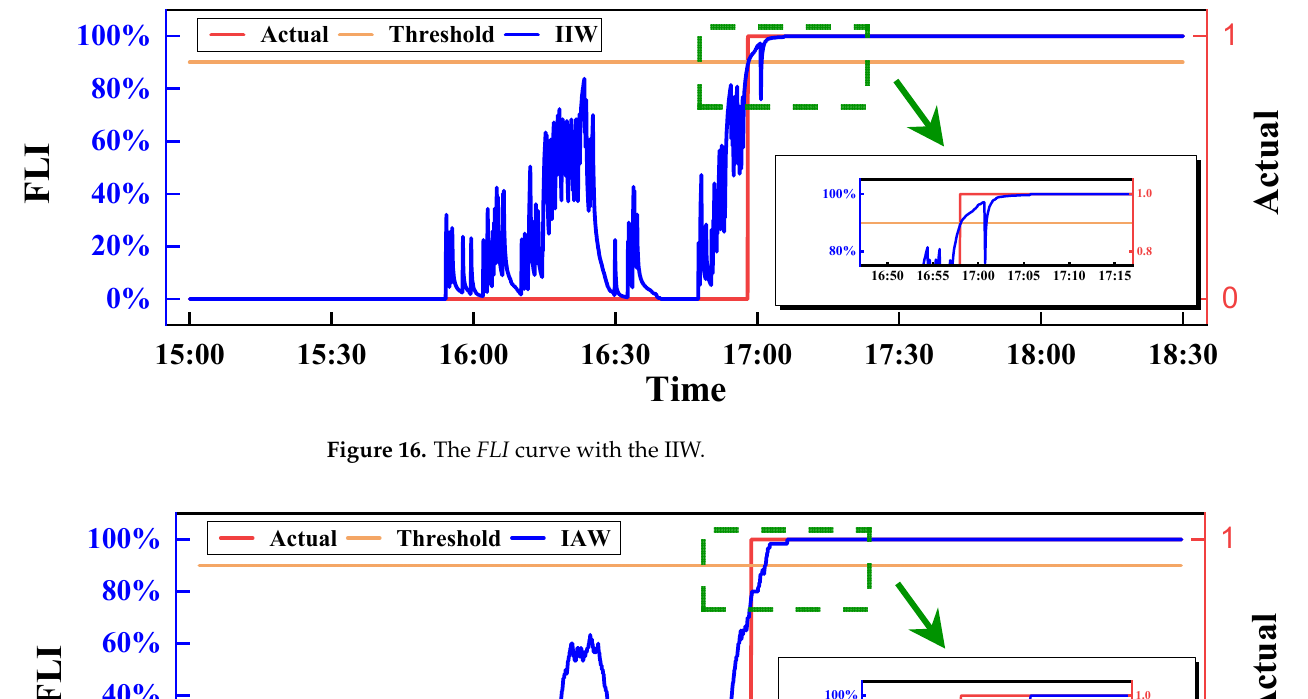
Figure 16. The FLI curve with the IIW.